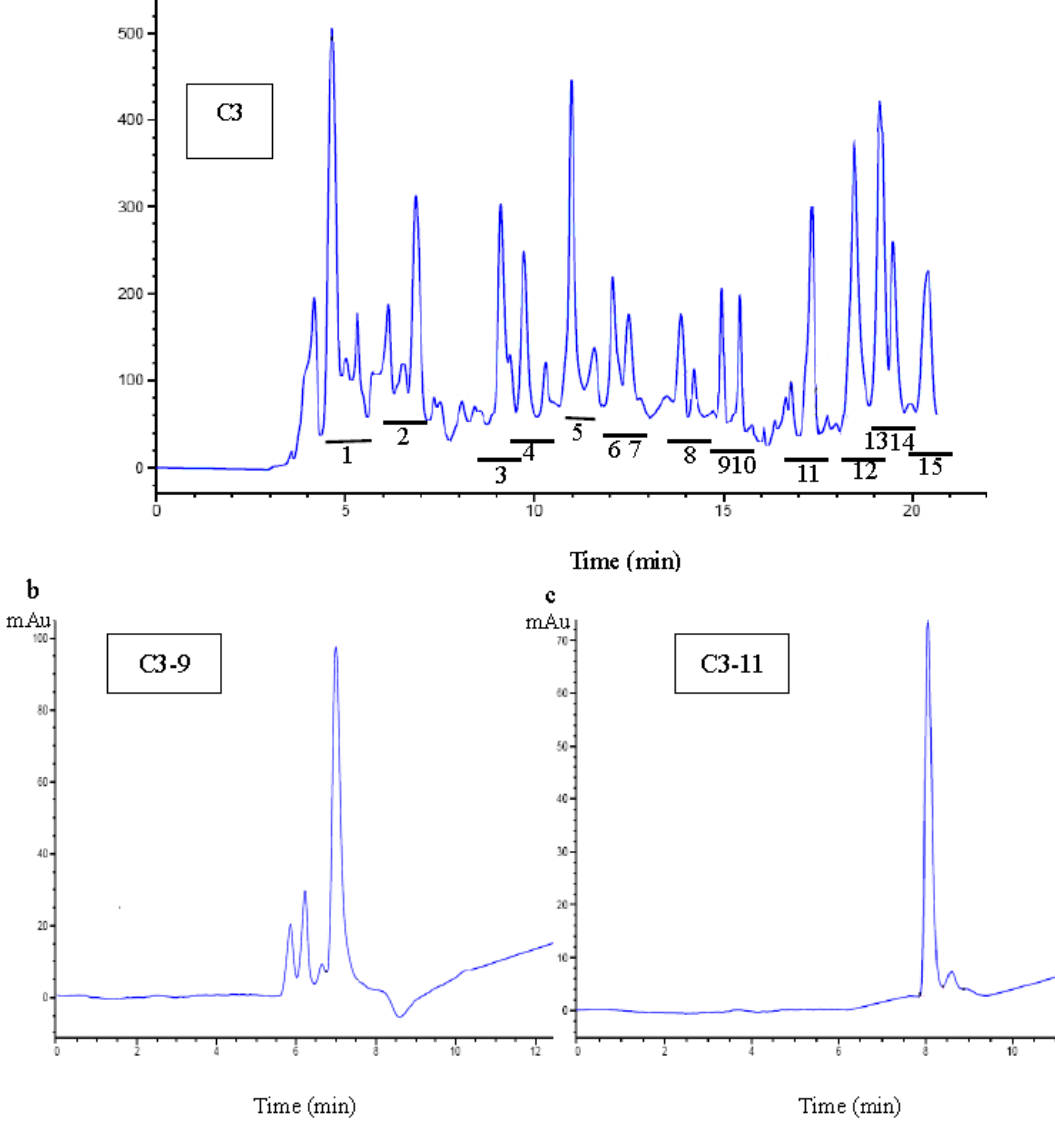
Figure 4. Chromatography of Fraction C3 was separated by semi-preparative RP-HPLC ( a ), and numbers 1–15 represented the elution peaks of C3-1–C3-15. Chromatography of C3-9 ( b ) and C3-11( c ) were further separated by RP-HPLC analytical